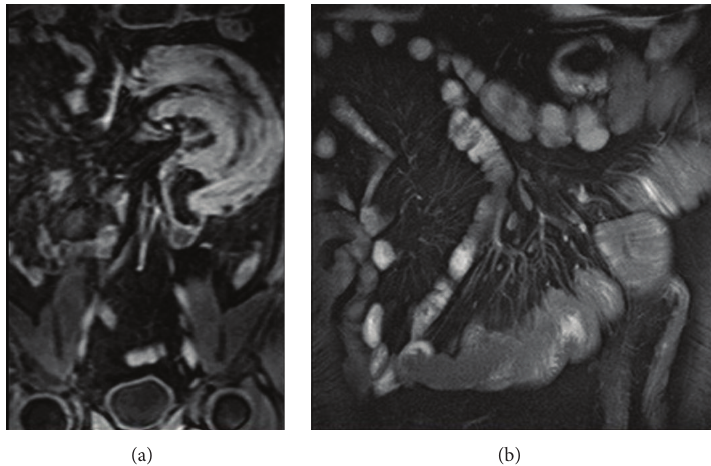
Figure 4: MRI, VIBE sequences after the i.v. contrast medium administration (a) and HASTE sequences (b): large mass with endophytic growth with intense and heterogeneous enhancement. Small lymph nodes are evident in the root of the mesentery. Definitive histology: metastases from melanoma.